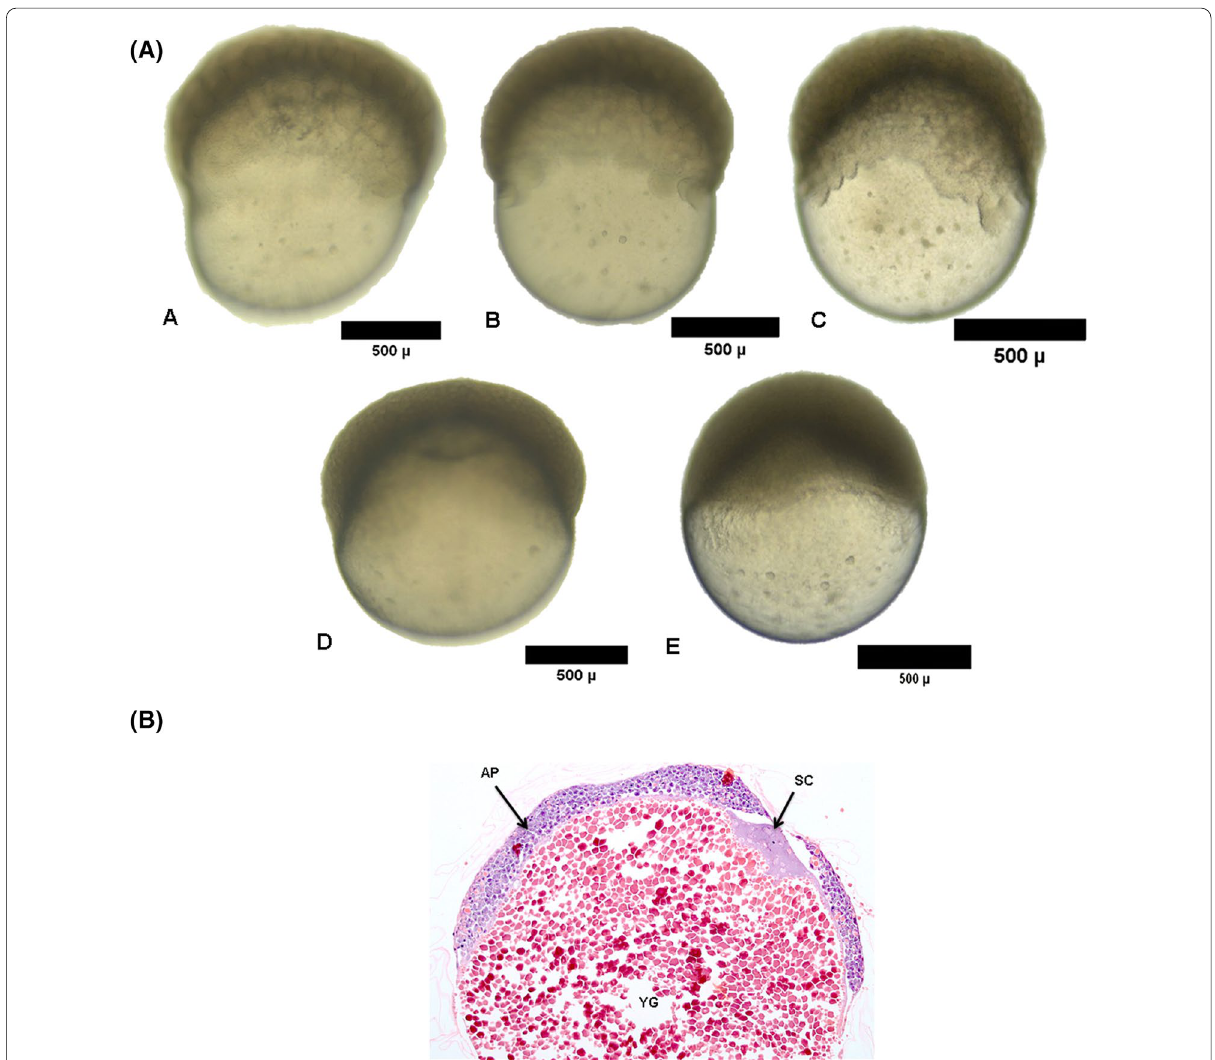
Fig. 4 A Prochilodus magdalenae , developmental blastula period from (A) 128C:128‑ cell; (B) 256C: 256‑cell; (C) 512:512‑cell; (D) > 1 K: High; to (E) 30% e.b.: 30% epiboly. B Prochilodus magdalenae , developmental blastula period. The cells are organized in more than 10 rows. A 10% epiboly stage is recognized, and a layer of elongated cells appears with slightly basophilic oval nuclei yolk syncytial layer (YSL) as part of the vitellus and support the animal pole, H&E 10X. Abbreviations: AP: animal pole; SC: syncytial cells; YG: yolk